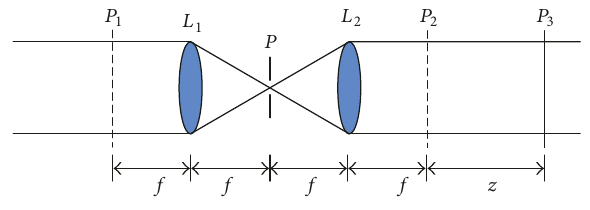
Figure 1: Spatial imaging